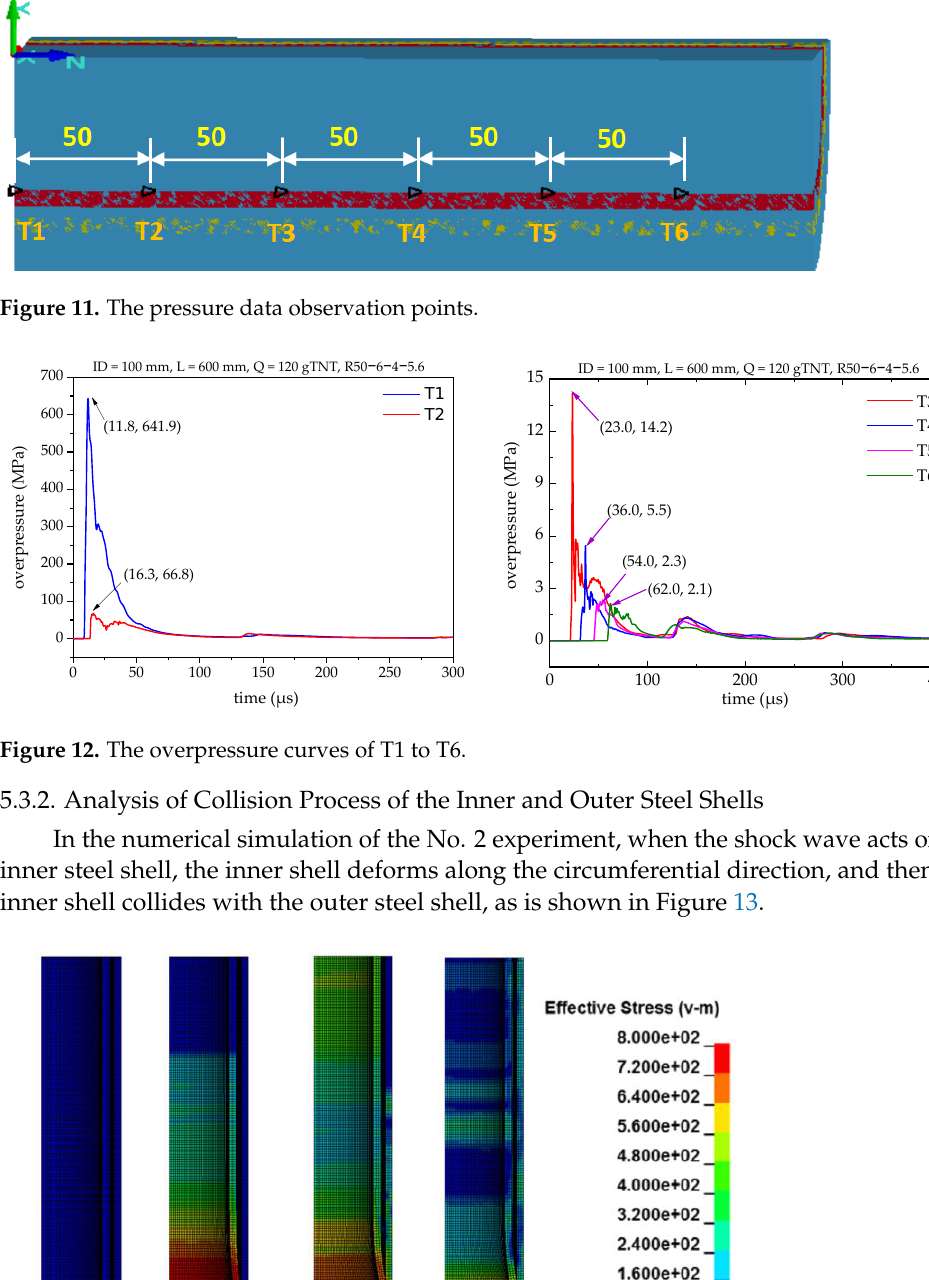
260 μs Figure 14. Collision process of double-layer steel cylindrical shells.